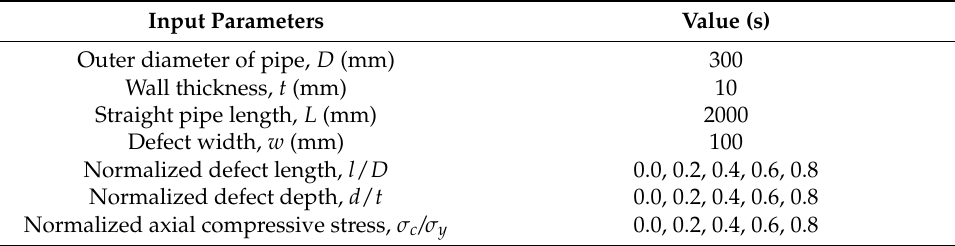
Table 2. Geometric parameters for finite element analysis (FEA) parametric